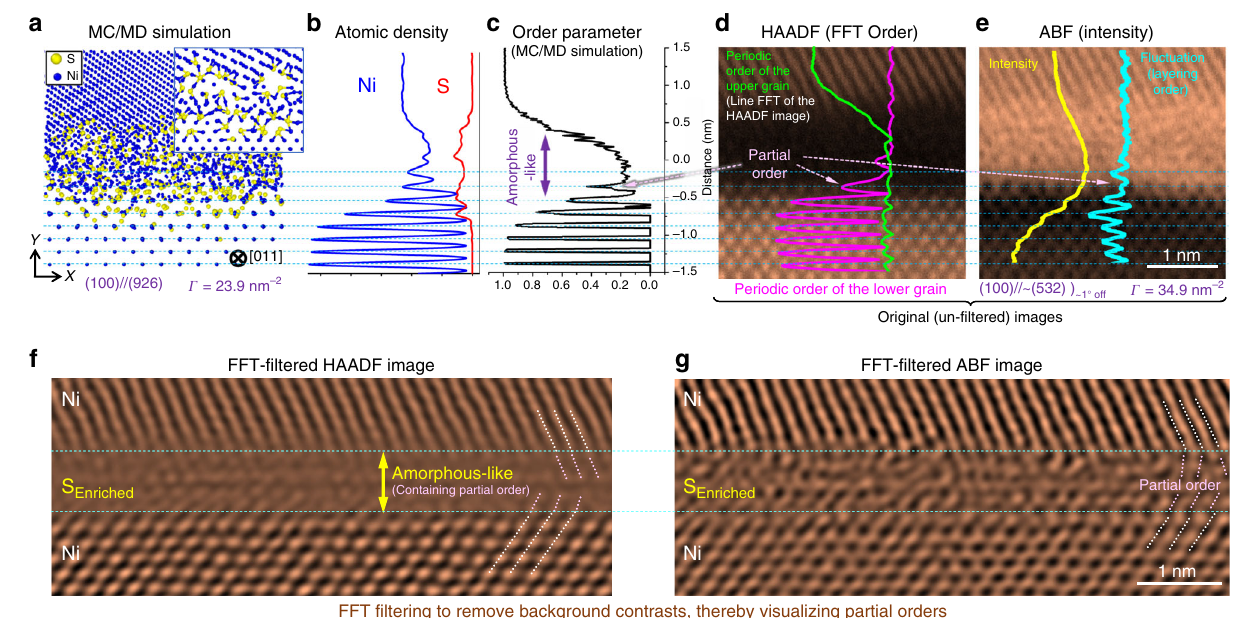
Fig. 3 Atomic structure of the Type A (amorphous-like) complexion or IGFs of an equilibrium thickness. a Hybrid MC/MD simulated (100)//(926) GB, where the inset is an enlarged and thinner section. The corresponding ( b ) Ni and S density pro fi les and ( c ) order parameter pro fi le. A pair of experimental ( d ) HAADF image (with overlapping periodic order pro fi les obtained from the line-by-line FFT) and ( e ) ABF image of the (100)//~(532) ~1° off GB facet (with overlapping intensity pro fi le and its fl uctuation, illustrating the layering order). FFT- fi ltered ( f ) HAADF and ( g ) ABF images to remove the background contrasts to reveal a bipolar distribution of partial structural orders within this amorphous-like intergranular fi lm (IGF)